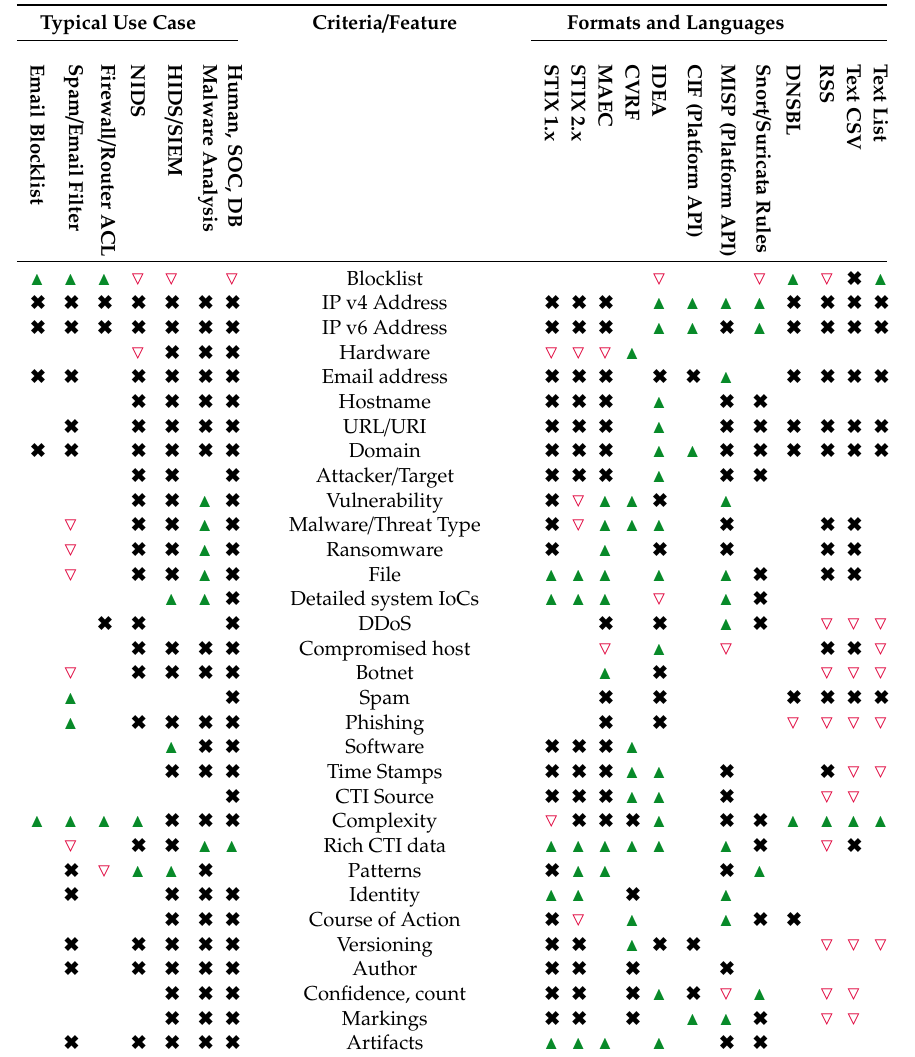
Table 7. Formats and languages, use case and features.